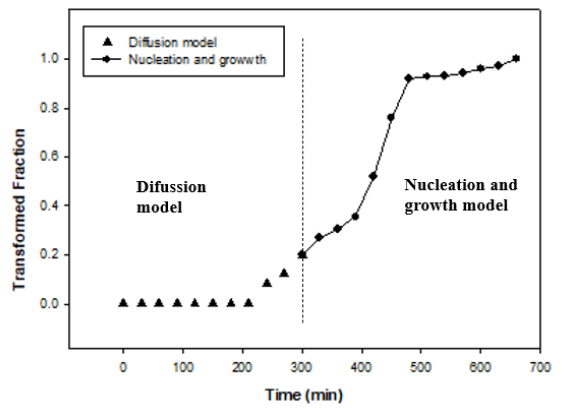
Figure 9. Mathematical models that describe the kinetics of transformation from β phase to α phase at 848 K. For the first stage, diffusion model is applied, while for the second stage it is the nucleation and growth model.